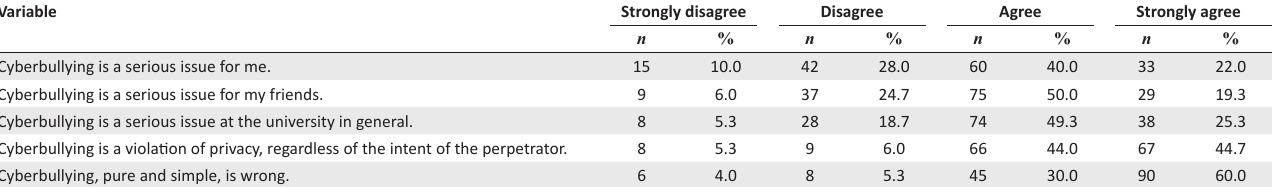
TABLE 5: Perception of seriousness of cyberbullying. Variable